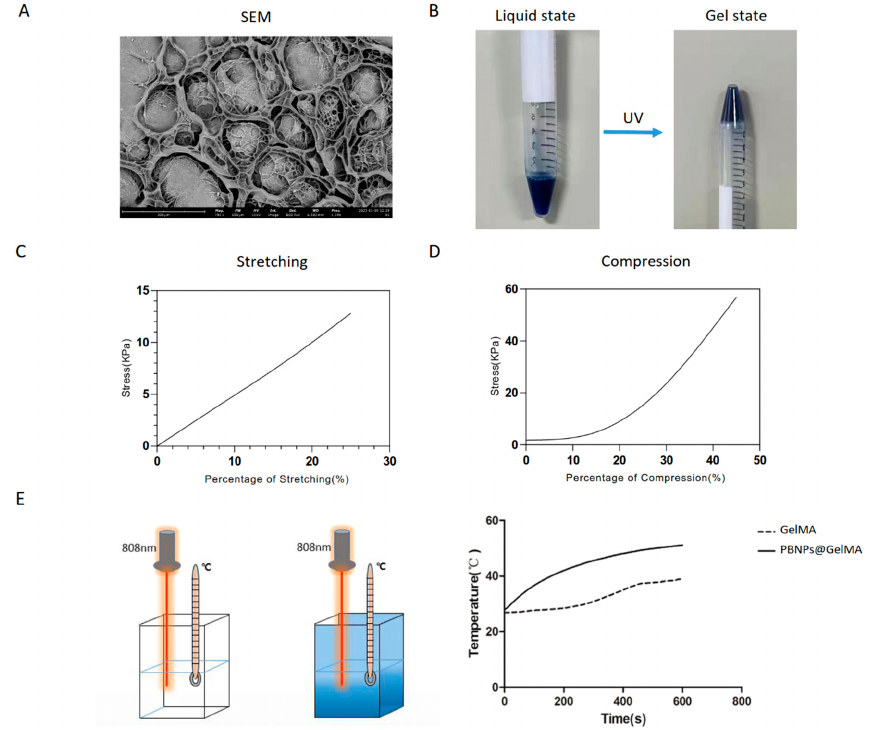
Figure 1. Characterization of PBNP@GelMA hydrogel. ( A ) SEM image. ( B ) The process of crosslink- ing. ( C ) Stretching test. ( D ) Compression test. ( E ) Temperature increase behavior. PBNP@GelMA was irradiated with 1.0 W/cm 2 of 808 nm laser, and temperature changes were detected.